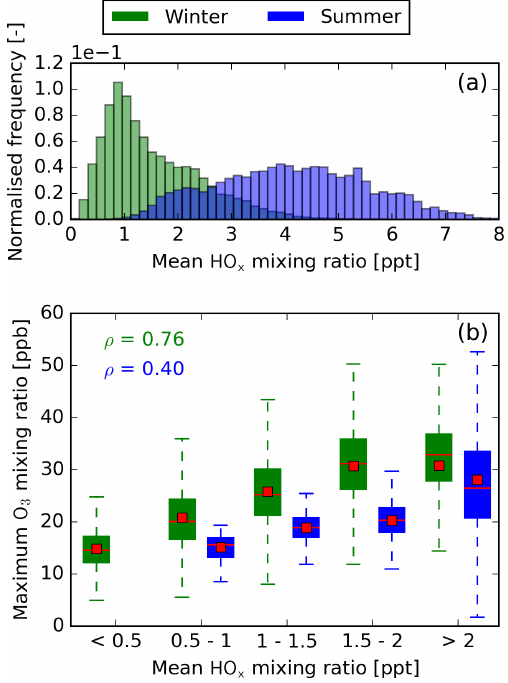
Figure 6. (a) Normalised histogram of the mean NO x mixing ra- tio until the O 3 maximum is reached. Results are normalised to the total number of air parcels in summer and winter, respectively. (b) Binned box plots showing the relation between the mean NO x mixing ratio and the magnitude of the O 3 maximum. The median and mean for each box plot are represented by red lines and red boxes, respectively. Additionally, the Spearman rank coefficient is given for summer and winter.